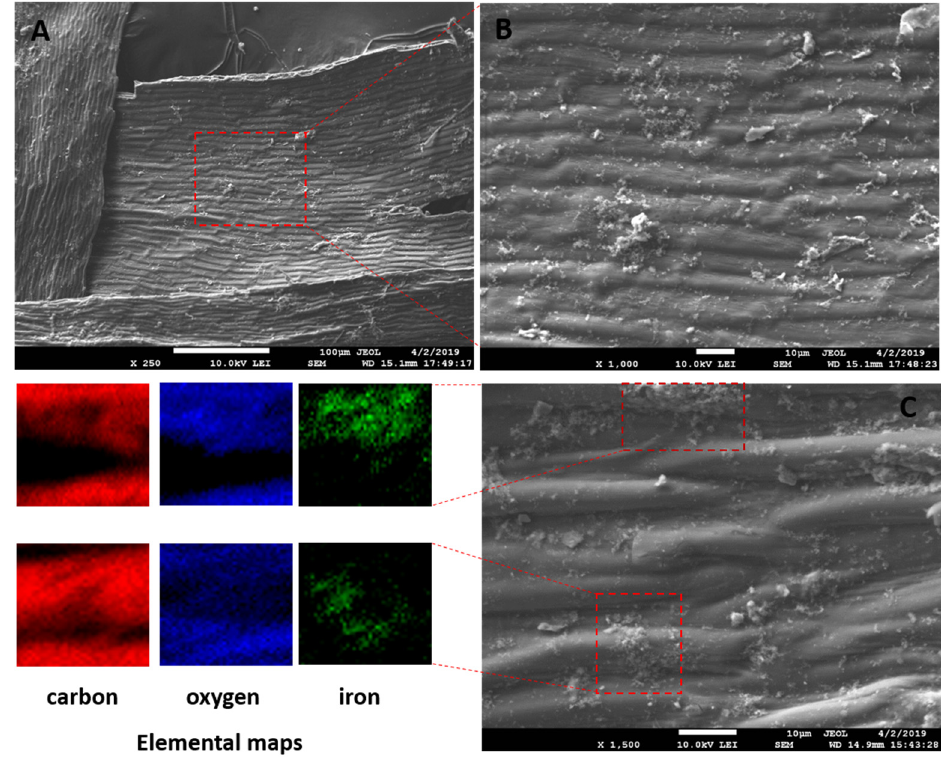
Figure 2. SEM and EDX images of magnetic responsive biomass of R. squarrosus . ( A ) Magnification 250 × , ( B ) 1000 × , ( C ) 1500 × . The SEM image in panel B represents the area closed by the red dashed line in panel A. EDX elemental distribution maps show the elemental (C, O and Fe) composition of areas closed by red dashed lines in panel C.